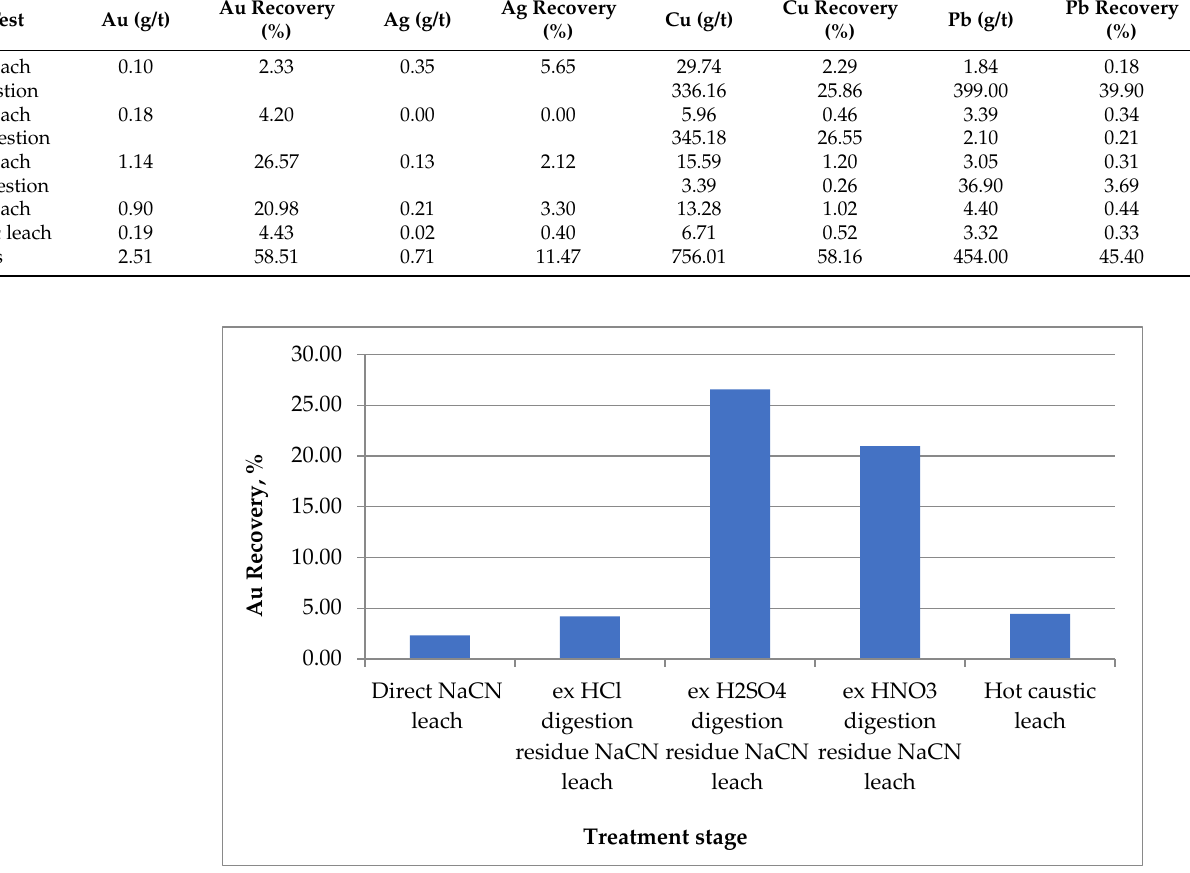
Figure 6. Cumulative recovery graph.